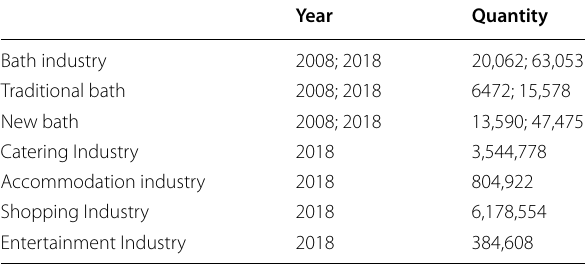
Table 1 Main categories of POI